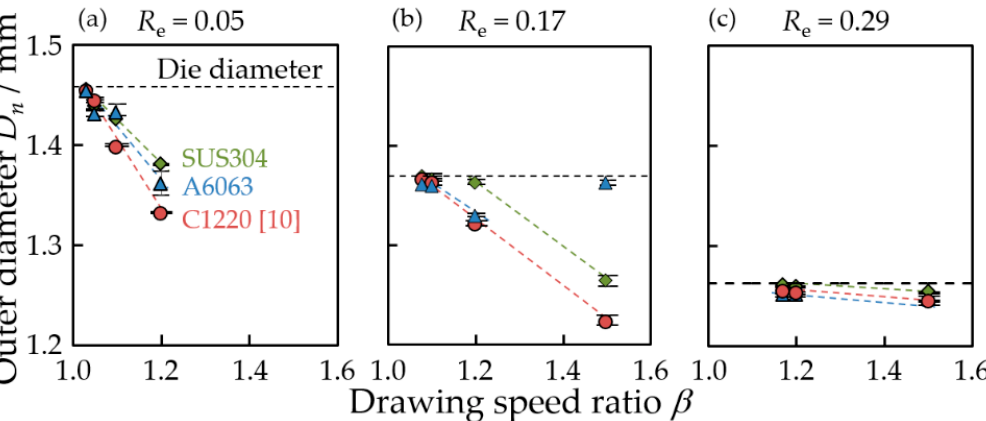
Figure 8. Outer diameters of the drawn tubes on the die exit side. ( a ) Die reduction R e = 0.05, ( b ) R e = 0.17, and ( c ) R e = 0.29. The error bars indicate the standard deviations. The dotted lines indicate the exit hole diameter of the die. The results of the copper tubes were already shown in our previous paper [10].